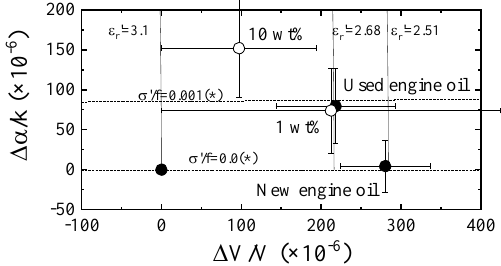
Figure 13. ( a ) Velocity and ( b ) attenuation changes for the water contained in engine oil obtained from the differential signal between Ch.1 and Ch.2.